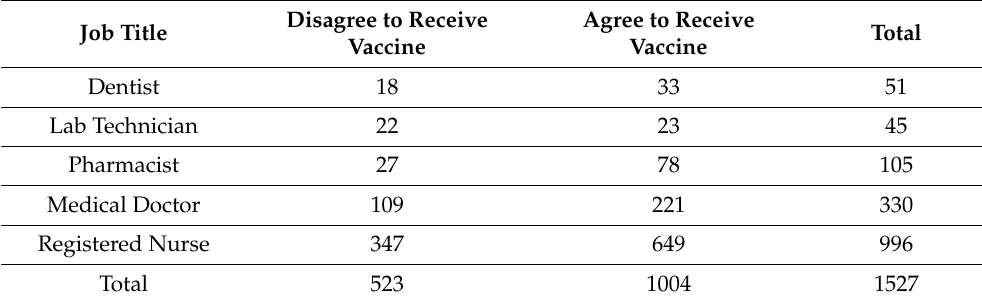
Table 2. Willingness of healthcare professionals to accept taking the hypothetical vaccine.